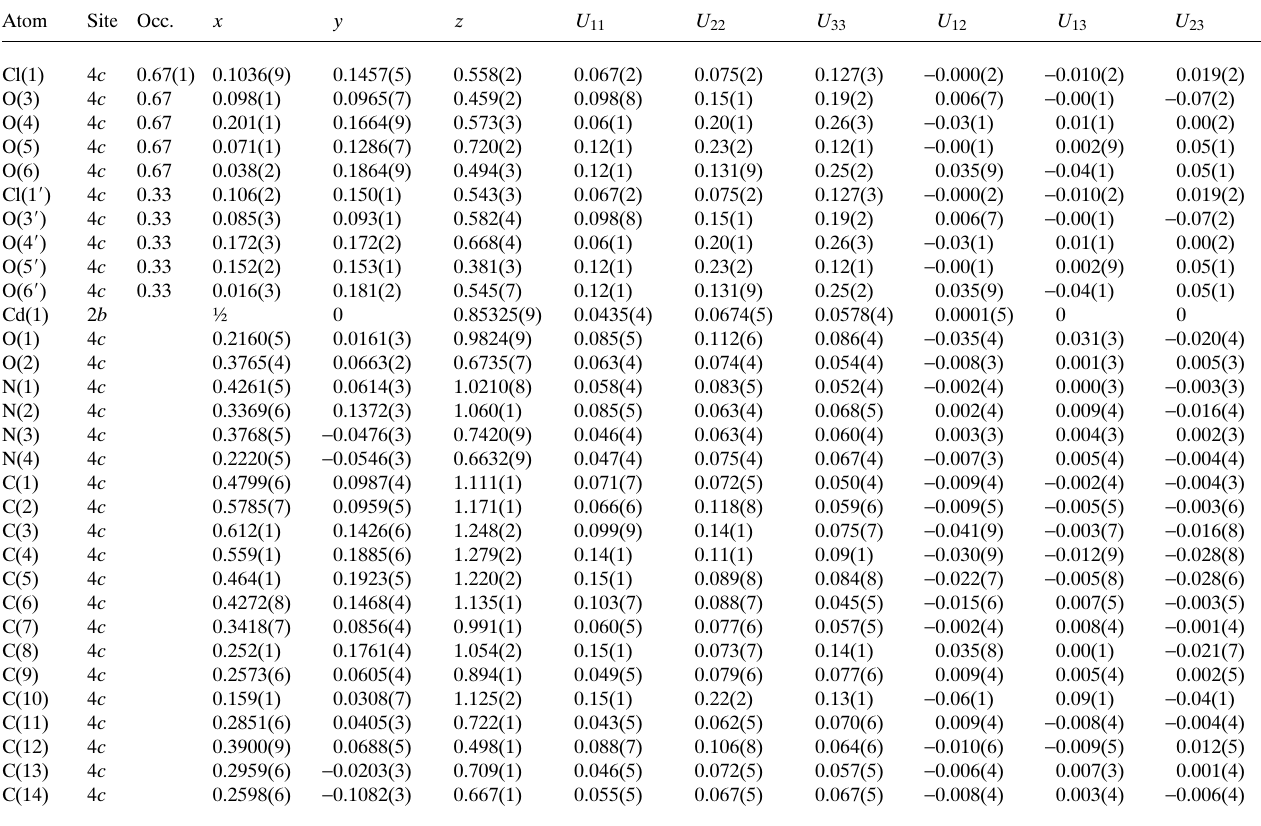
Table 3. Atomic coordinates and displacement parameters (in Å 2 )